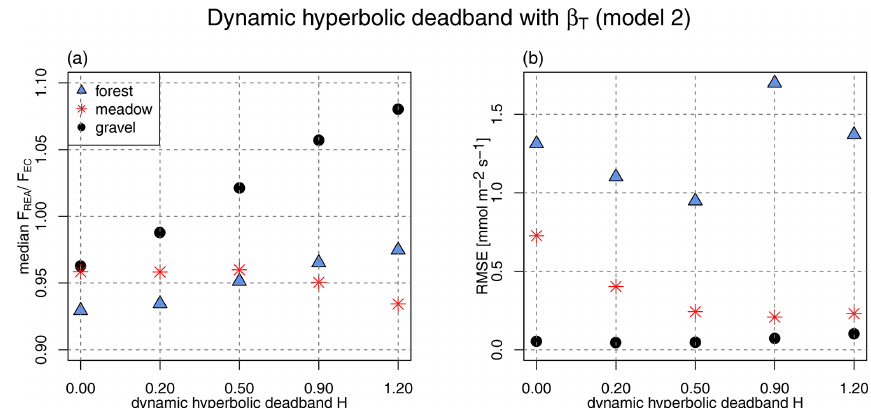
Figure 6. Errors as a function of dynamic hyperbolic deadband size. The x axis is the H parameter in Eq. (10), which defines the deadband size. (a) Median F REA /F EC (latent heat flux simulated with sensible heat as a proxy) ratio for each of the simulated dynamic deadband sizes; (b) RMSE for each of the simulated dynamic deadband sizes.